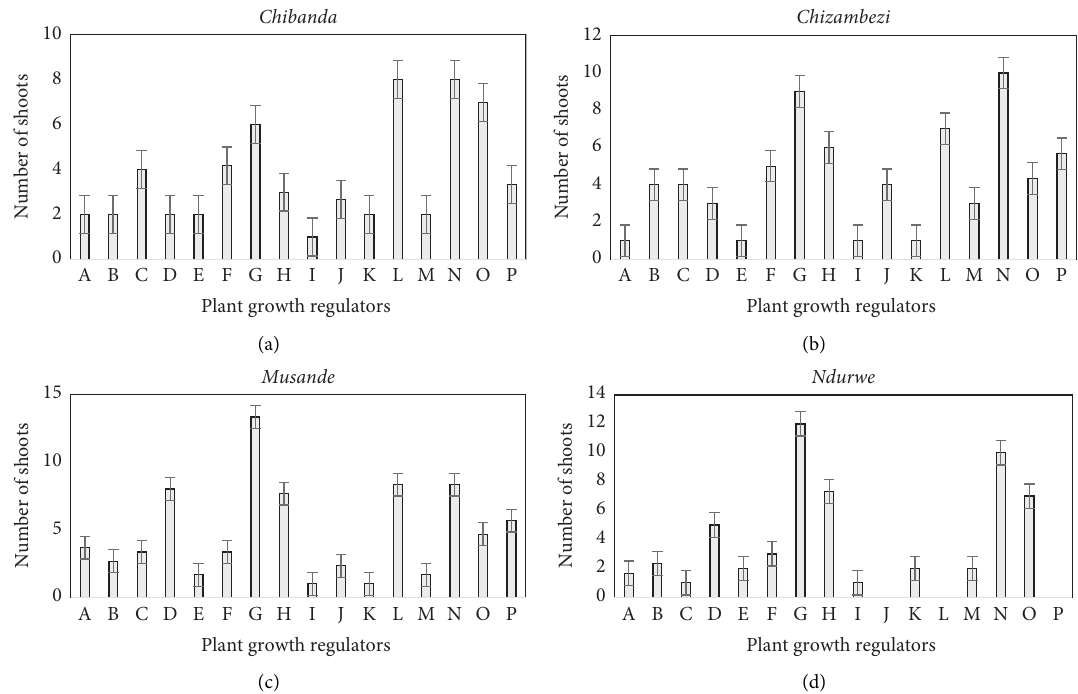
Figure 3: Mean shoot number of the Livingstone potato landraces in response to NAA: BAP in mg/l application. P < 0 . 001, LSD � 2.57. Error bars represent standard errors of the differences. Plant growth regulators key: A (0mg/l:0mg/l), B (0mg/l:0.5mg/l), C (0mg/l:1mg/l), D (0mg/ l:2mg/l), E (0.2mg/l:0mg/l), F (0.2mg/l:0.5mg/l), H (0.2mg/l:2mg/l), I (0.5mg/l:0mg/l), J (0.5mg/l:0.5mg/l), J (0.5mg/l:0.5mg/l), K (0.5mg/l:1mg/l), L (0.5mg/l:2mg/l), M (1mg/l:0mg/l), N (1mg/l:0.5mg/l), O (1mg/l:1mg/l), and P (1mg/l:2mg/l).